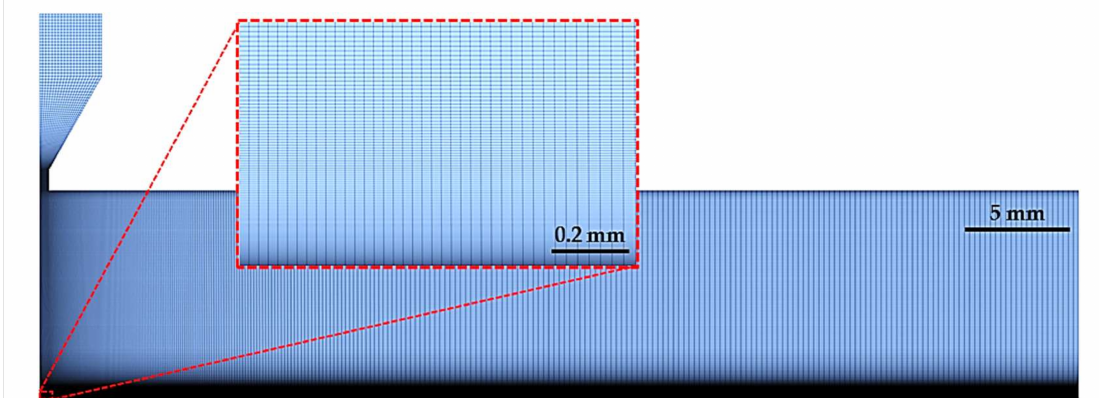
Figure 5. Mesh resolution of the 2D domain with detail of the impingement